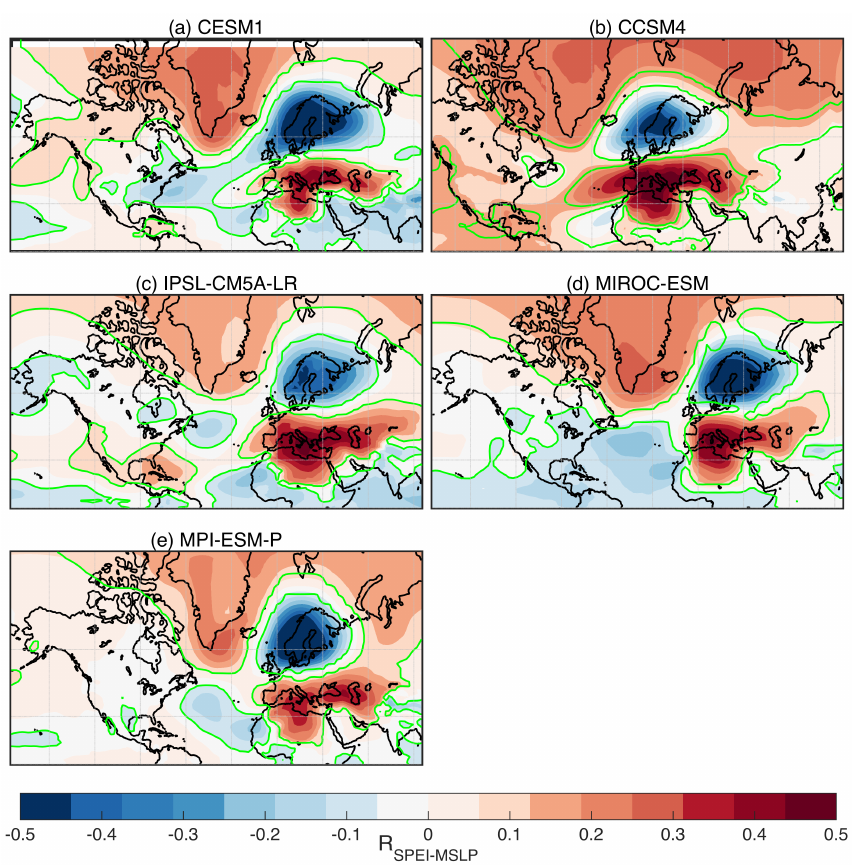
Figure 6. Spatial distribution of the correlation coefficient of northern European warm-season hydroclimate and mean sea level pres- sure (MSLP). Same as Fig. 5, but for the 850–1849CE